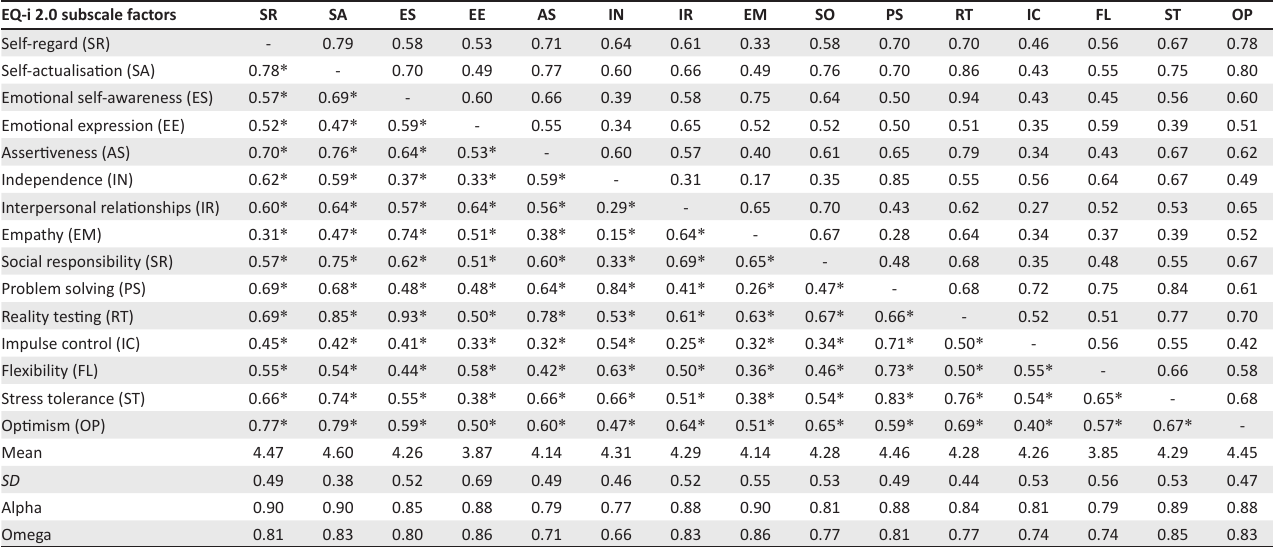
TABLE 1: Descriptive statistics for the EQ-i 2.0 subscale factors. EQ-i 2.0 subscale factors